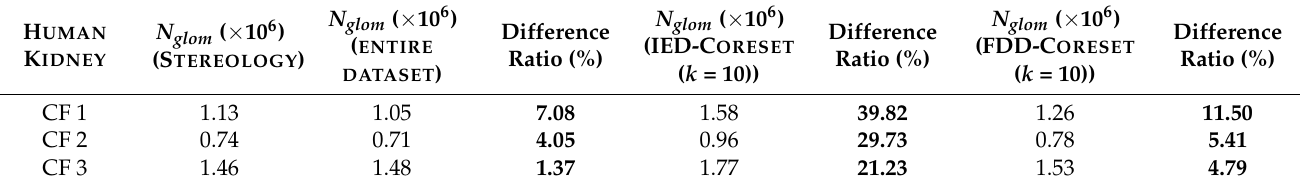
Table 5. Human kidney glomerular segmentation results ( N glom ) using BlobGAN trained on entire dataset (1000 Random Samples), IED-Coreset ( k = 10) and proposed FDD-Coreset ( k = 10) comparing with stereology.